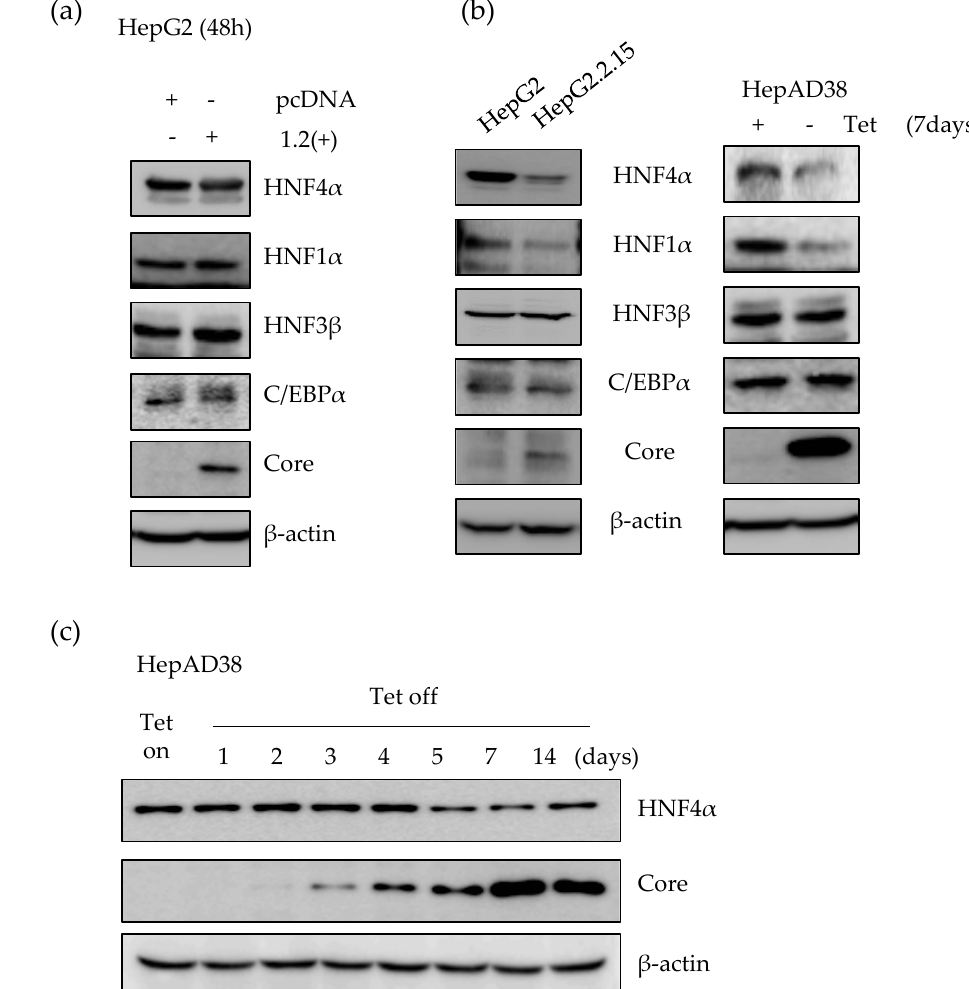
Figure 1. Expression level of HNF4 α in early stage and long-term of HBV expression in vitro. ( a ) HBV 1.2mer (1.2( + )) plasmid was transfected into the HepG2 cells. Cells were then harvested at 48 h after transfection. The level of proteins was analyzed by Western blot. ( b ) Expression levels of transcription factors in HepG2, HepG2.2.15, and HepAD38 cell lines was determined by Western blot. In HepAD38 cell line, the complete medium without tetracycline, was used for 7 days in order to induce HBV production. ( c ) The expression level of HNF4 α in HepAD38 cell line at indicated time points was determined in the absence of tetracycline. The data represent the results from three independent